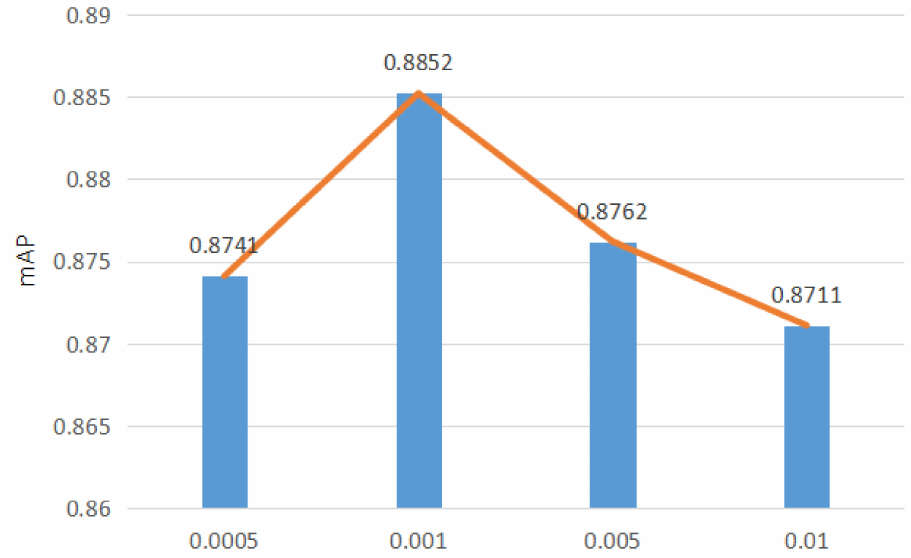
Figure 8. Effects of Learning Rate